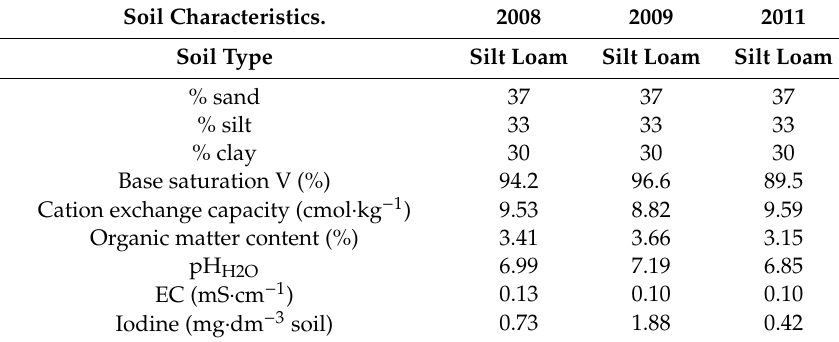
Table 1. Soil characteristics before potato cultivation in each year of the experiment.